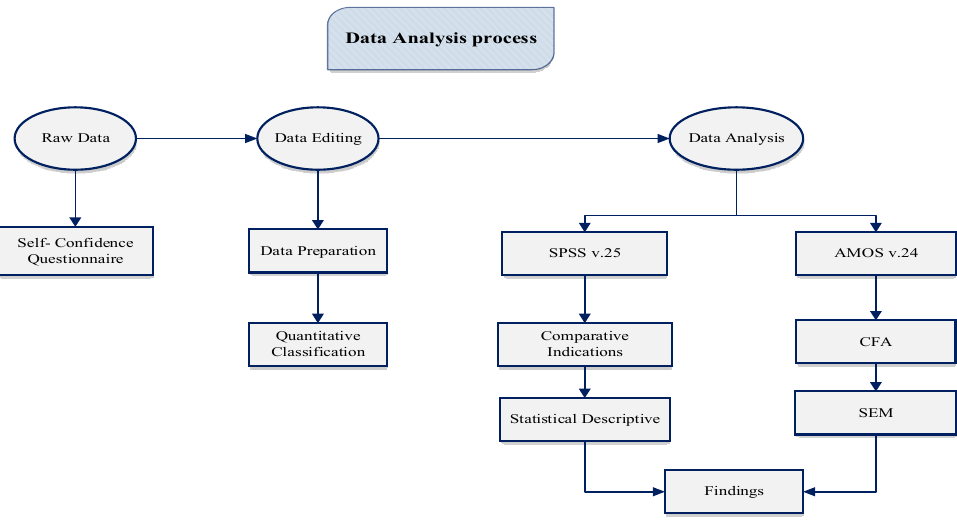
Figure 2. Data analysis process. Own elaboration.